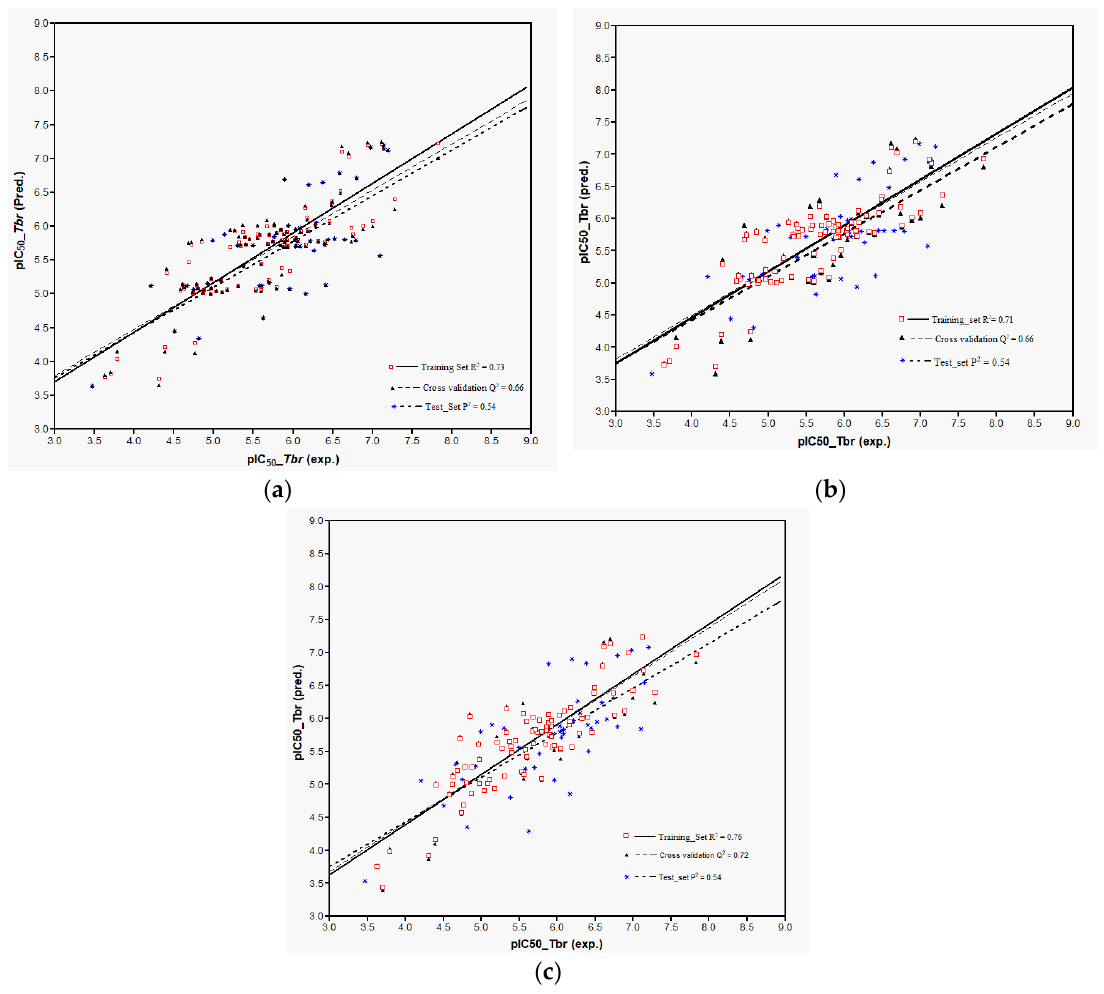
Figure 6. Plot of predicted versus experimental pIC 50 values as obtained from the QSAR Models 3 ( a ), 4 ( b ), and 5 ( c ).